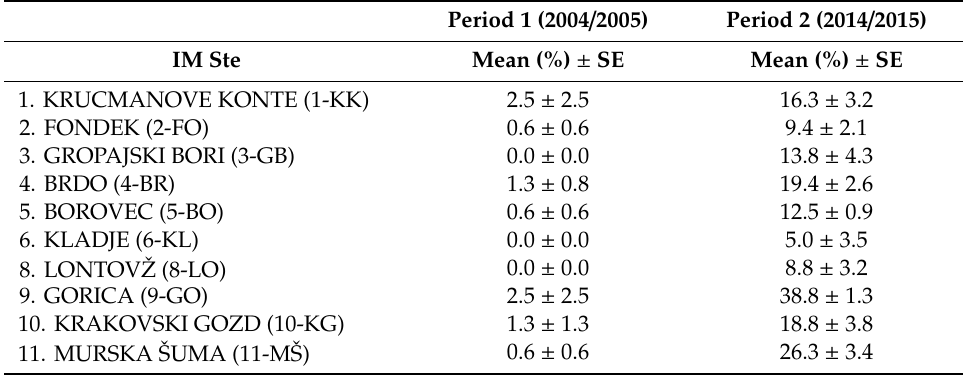
Table 5. Estimated disturbances in P1 (2004 / 2005) and P2 (2014 / 2015) for each IM